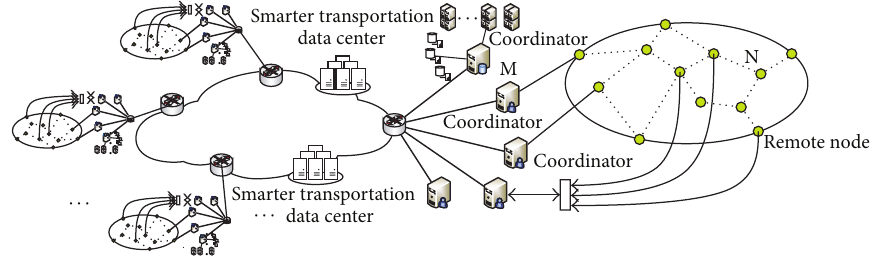
Figure 3: Processing architecture of stratified transportation stream